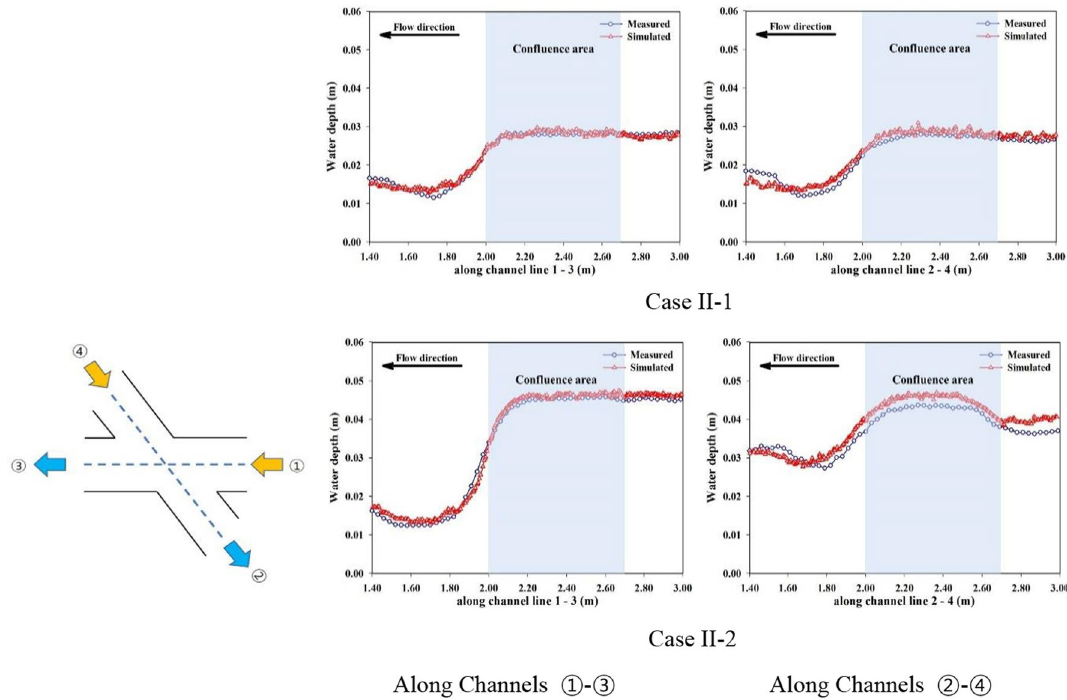
Fig. 10 Water-surface profiles along channels for Case